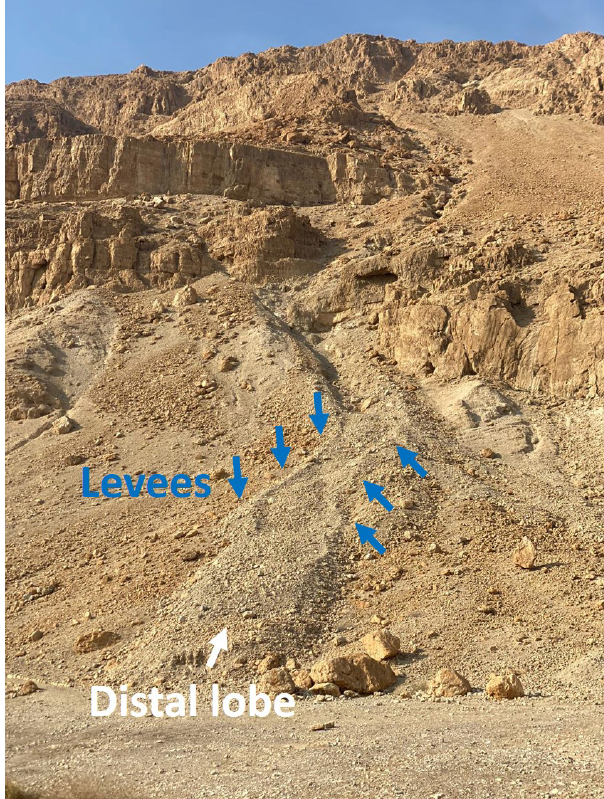
Figure 3. An example of debris flow deposits triggered prior to 2013. A distal lobe (white arrow), two levees (blue arrows), and a wide and shallow channel in between them at the end of the ephemeral stream drained the cliff area.